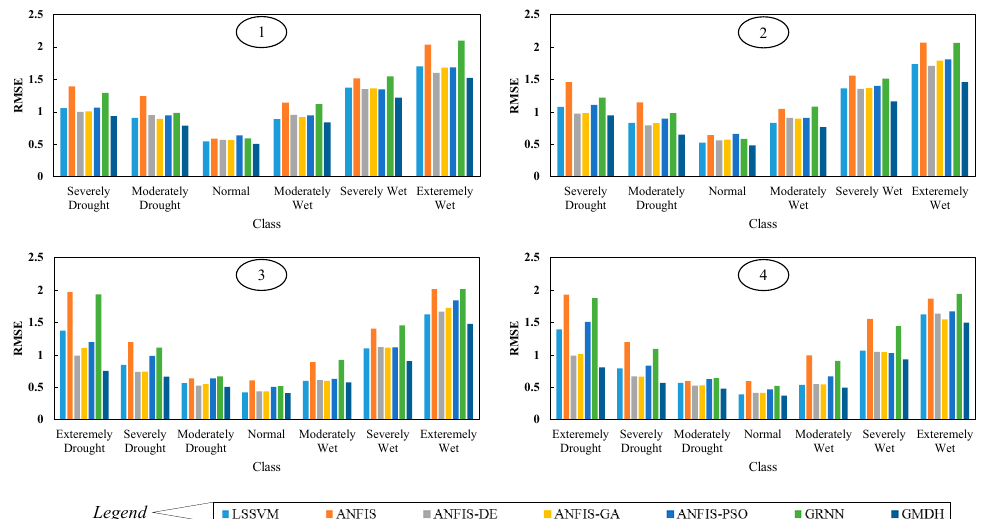
Figure 8. Root mean squared error (RMSE) values in drought classes; JDI’s prediction resulted by inputs of gamma test (1) and entropy theory (2) and MSPI’s prediction resulted by inputs of gamma test (3) and entropy theory (4).